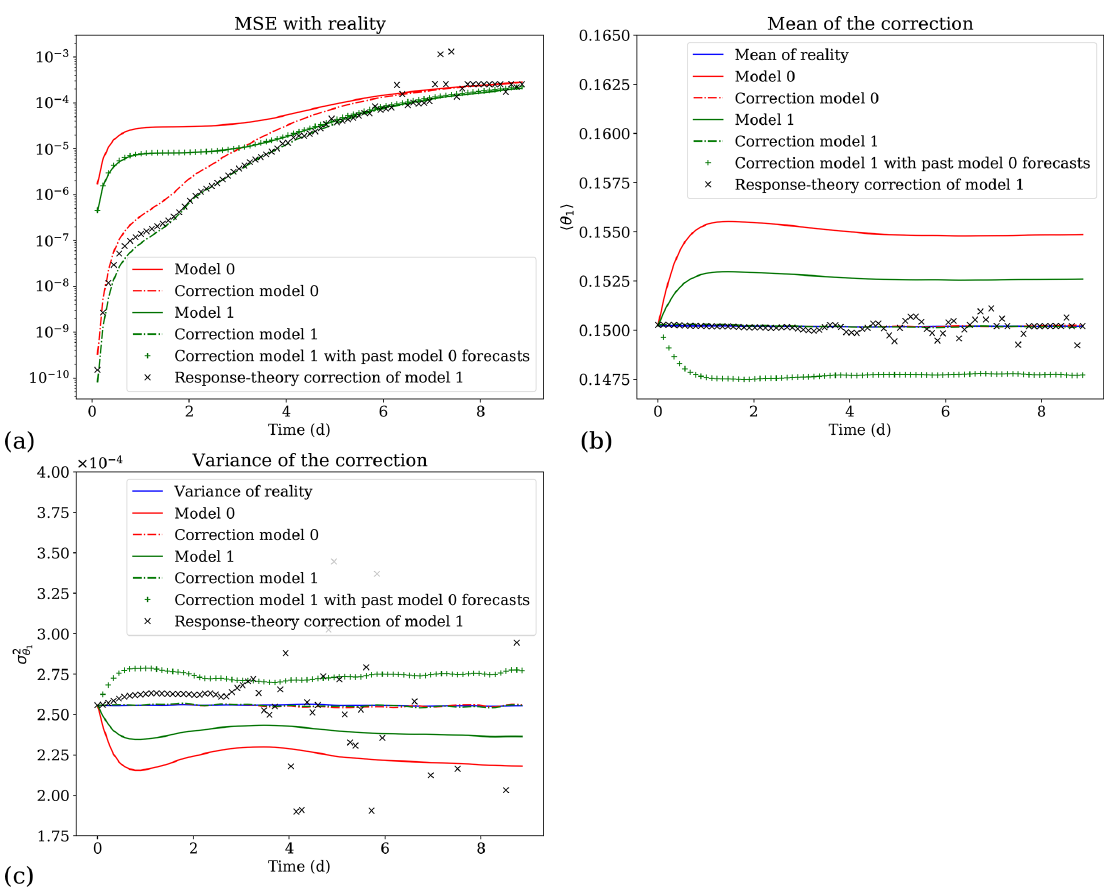
Figure 10. Performance of the corrections on the variable θ 1 for the experiment with the modification of the Newtonian cooling coefficient. (a) Mean square error (MSE) evolution between the different forecasts and their correction and reality. (b) Mean of the different trajectories (reality, model 0 and model 1) and corrected forecasts. (c) Variance of the different trajectories and corrected